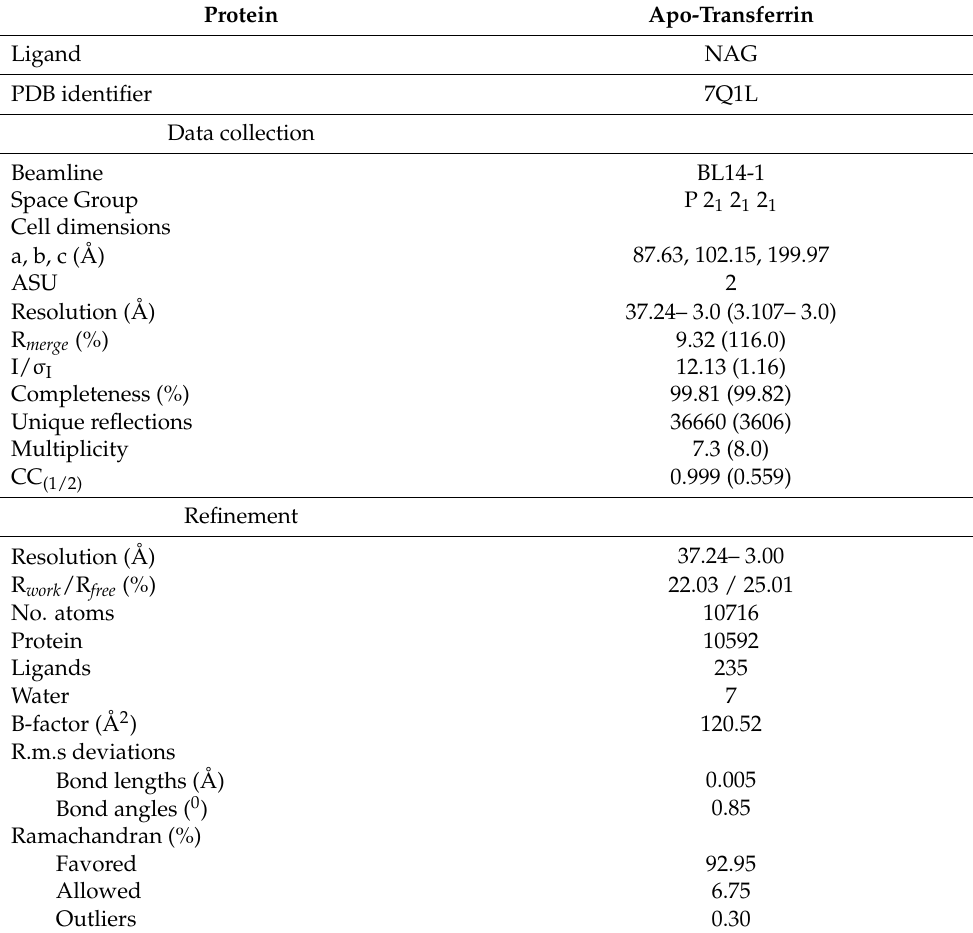
Table 1. Data collection and refinement statistics (values in parentheses are for highest-resolution